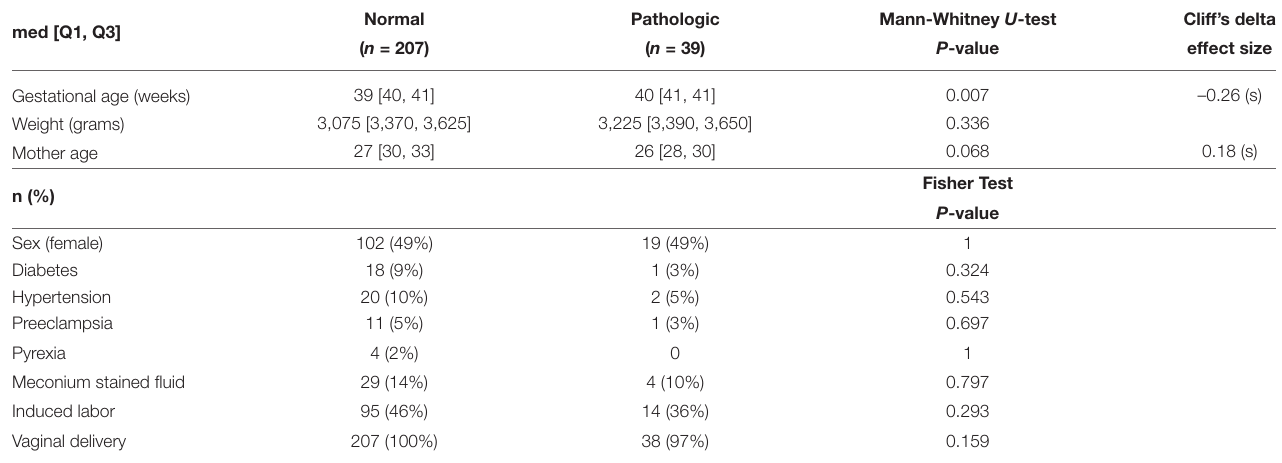
TABLE 1 | Patient and labor characteristics for the CTU-UHB database (25).